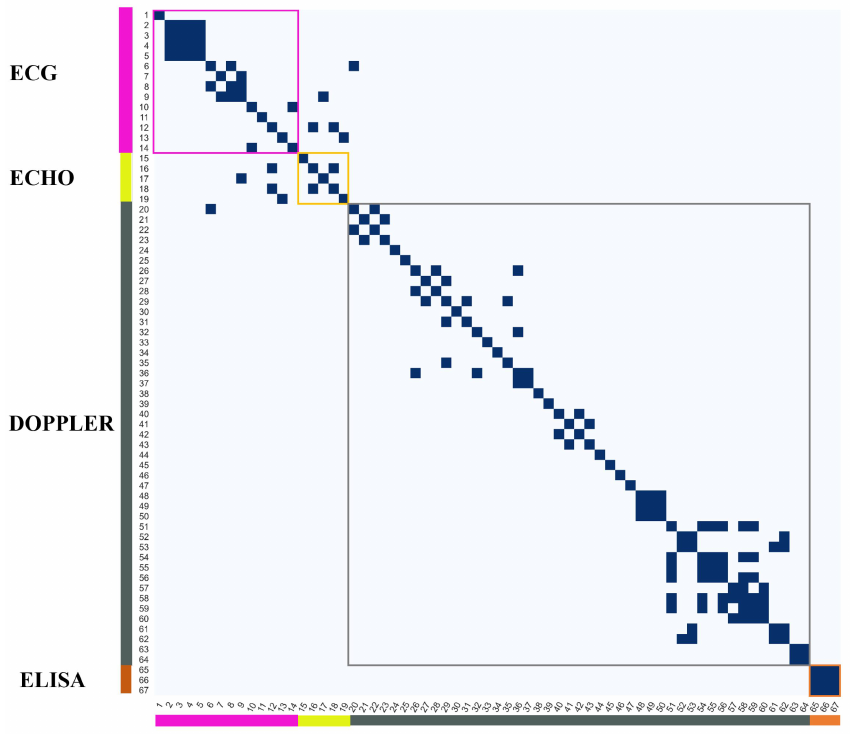
Figure 4. Univariable Pearson correlation map (r ≥ 0.70) for Multimodal Analysis for general T. cruzi Infection (ECG, ECHO, Doppler, and